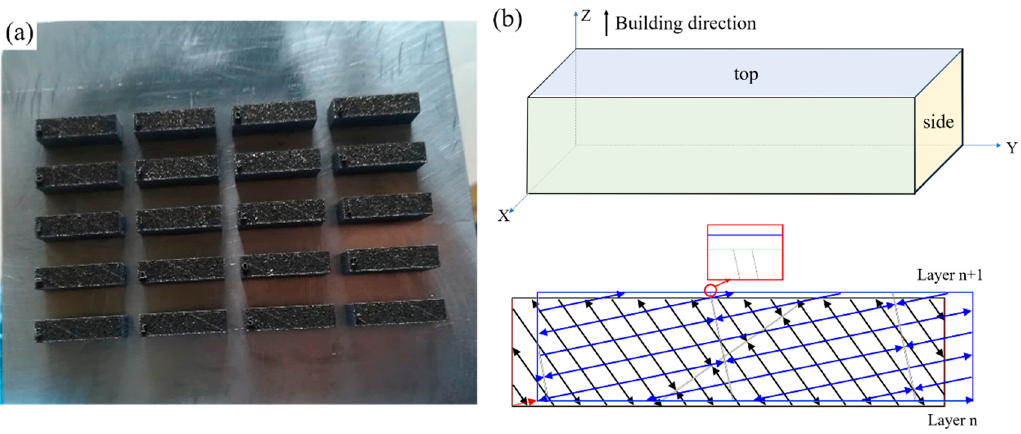
Figure 1. Images of ( a ) selective laser melting (SLM) processed bending samples and ( b ) the scanning strategy used for SLM.